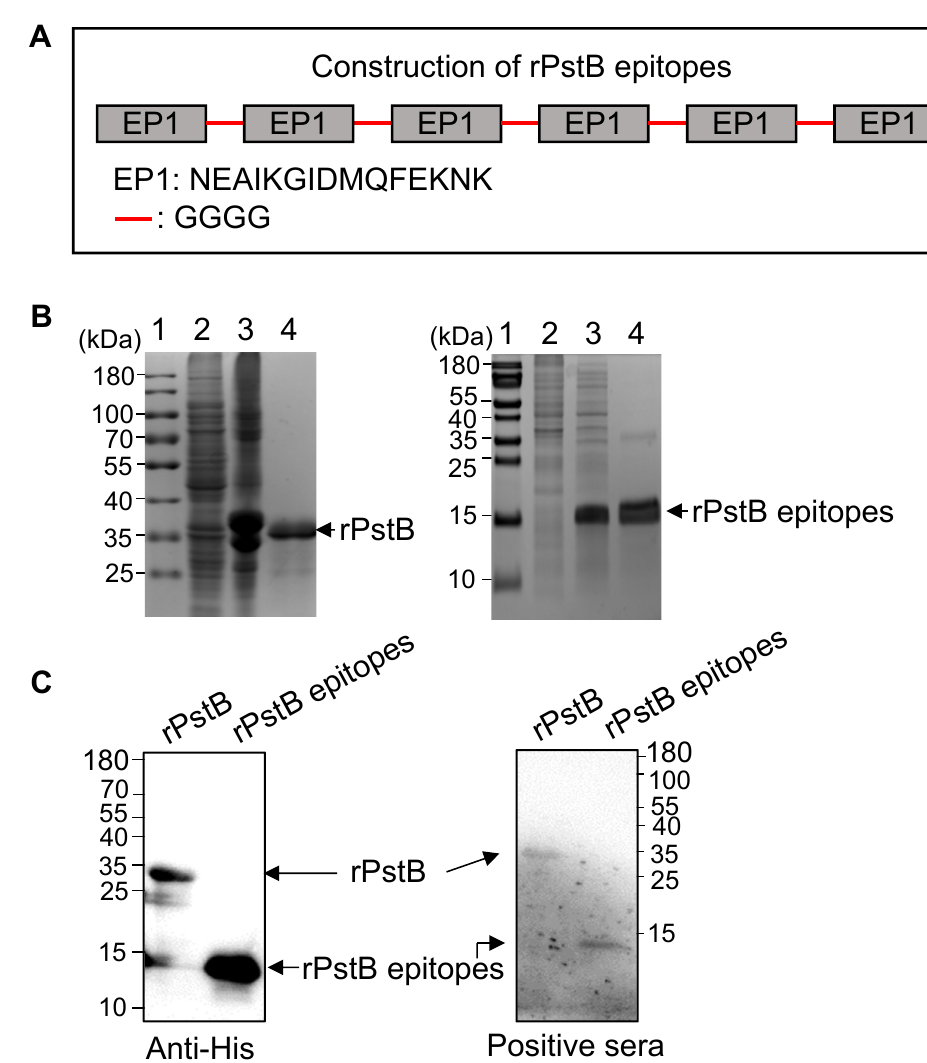
Figure 3. Expression and purification of rPstB and rPstB epitopes. ( A ) Designation of the rPstB epi- topes. The EP1 was tandemly strung with a linker of GGGG for expression in E. coli . ( B ) SDS-PAGE analysis of recombinant proteins. The rPstB and rPstB-epitopes were expressed in E. coli and purified using a Ni–NTA column. Lane 1, protein marker. Lane 2, uninduced bacterial cells. Lane 3, bacterial cells induced with isopropyl- β -D-thiogalactopyranoside (IPTG). Lane 4, purified recombinant pro- teins. ( C ) Western blot analysis of rPstB and rPstB-epitopes. The purified rPstB and rPstB-epitopes were detected by with anti-His antibodies and rabbit sera specific to S. suis serotype